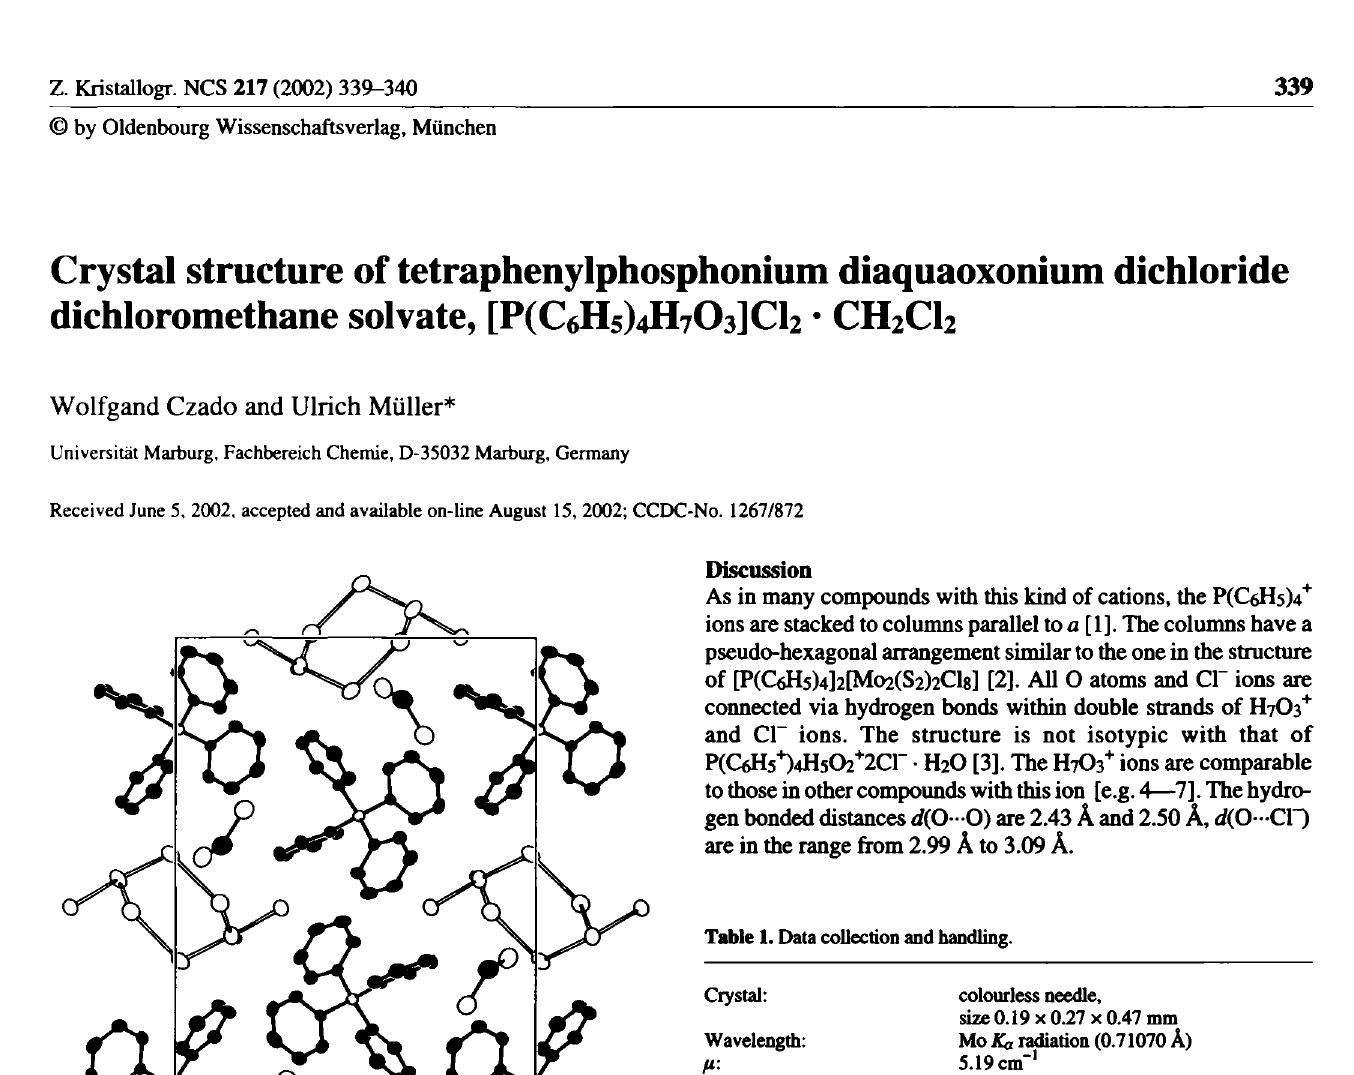
Table 2. Atomic coordinates and displacement parameters (in Ä 2